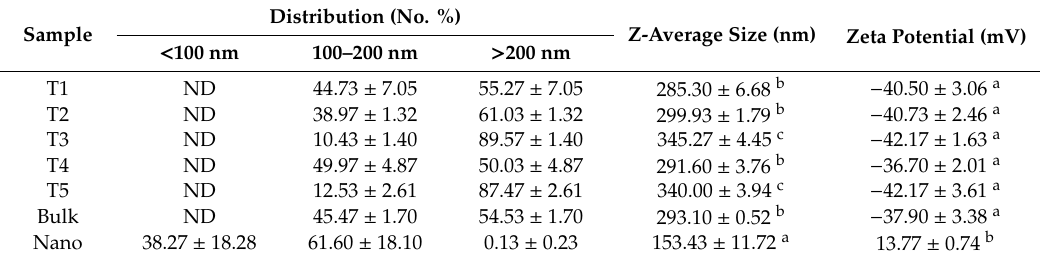
Table 2. Size distributions, hydrodynamic radii, and zeta potentials of food additive TiO 2 (T1–T5) and general-grade bulk and nano TiO 2 (bulk and